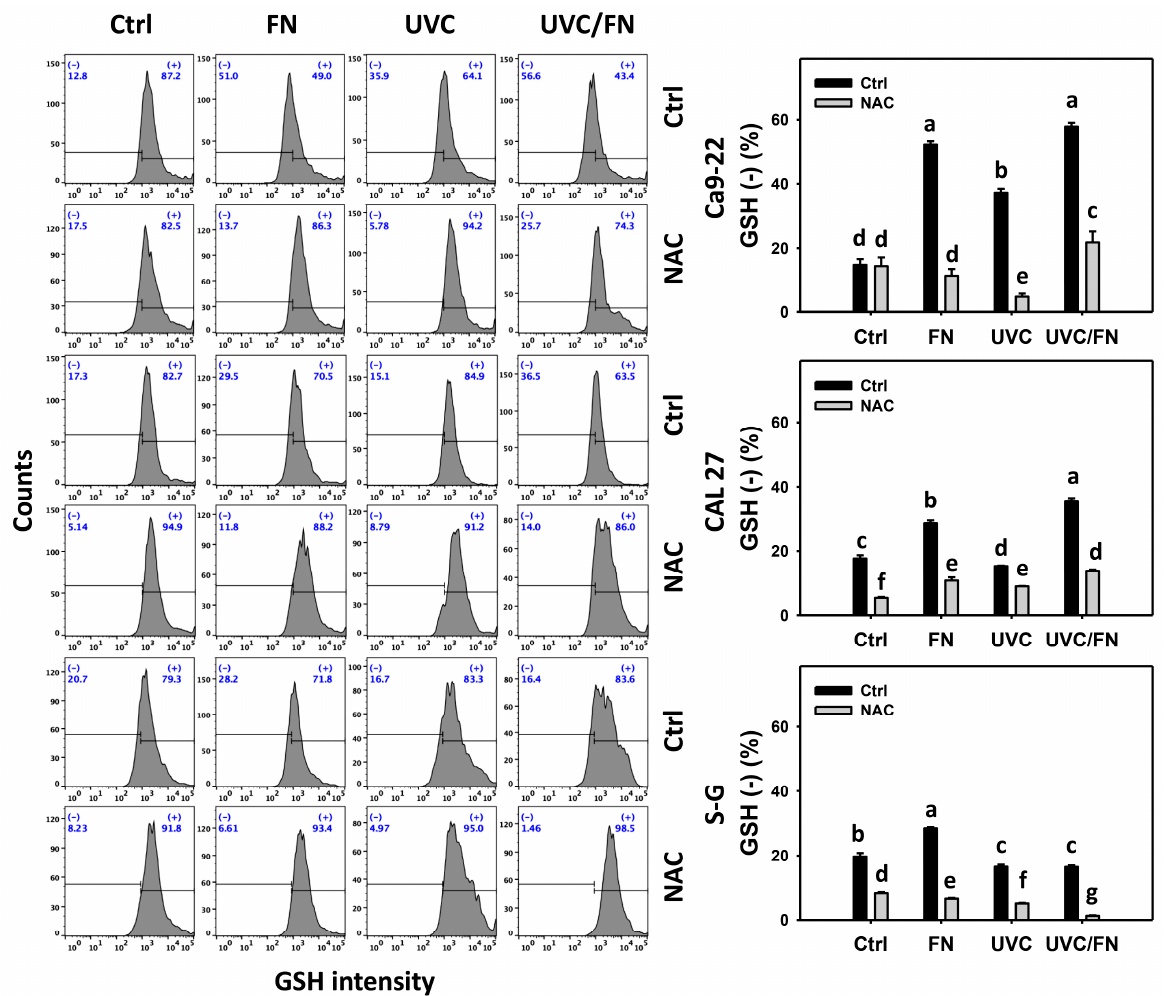
Figure 8. GSH determination. There are four kinds of treatmentss for oral cancer and non-malignant oral (S–G) cells: control, FN (300 μ g/mL), UVC (10 J/m 2 for Ca9-22; 15 J/m 2 for CAL 27 and S–G), and UVC/FN (10 J/m 2 /300 μ g/mL for Ca9-22; 15 J/m 2 /300 μ g/mL for CAL 27 and S–G). NAC indicates that cells were pretreated with 10 mM NAC. Their intensity changes were evaluated by flow cytom- etry after 24 h treatment. GSH ( − ) populations are indicated with ( − ). Data are given as means ± SD ( n = 3). Lower-case letters indicate significant differences when non-overlapping ( p < 0.05).